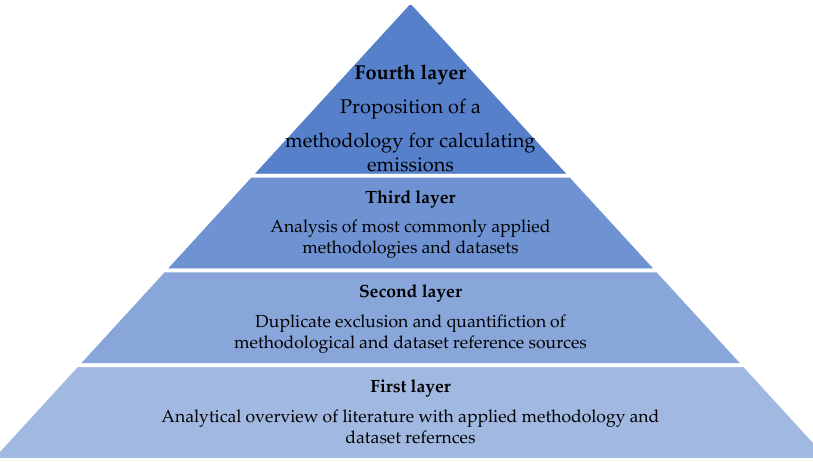
Figure 1. Bottom-up multi-layered analysis approach.